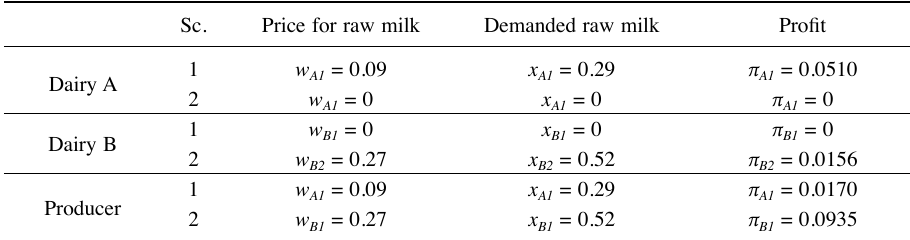
Table 2. Numerical example of the basic